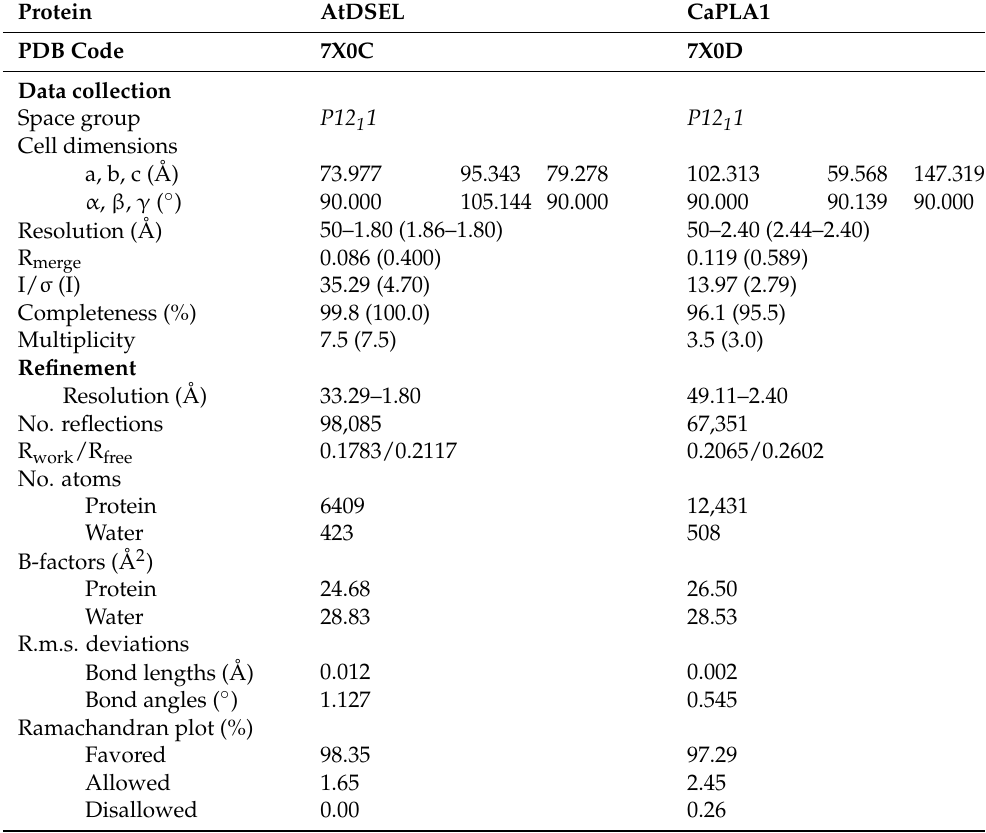
Table 1. Summary of data collection and refinement of AtDSEL and